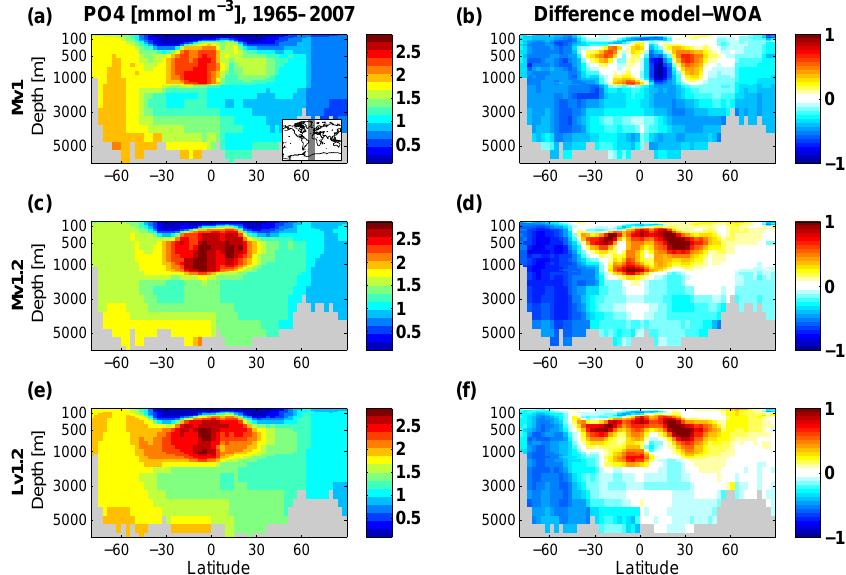
Figure 11. Zonal mean phosphate concentration (mmolm − 3 ) along the grey shaded region in the Atlantic/Southern Ocean indicated in the inset in panel (a) averaged over the years 1965 to 2007 for the model configurations (a) Mv1, (c) Mv1.2, and (e) Lv1.2. Panels (b) , (d) , and (f) show the differences with respect to the World Ocean Atlas gridded data